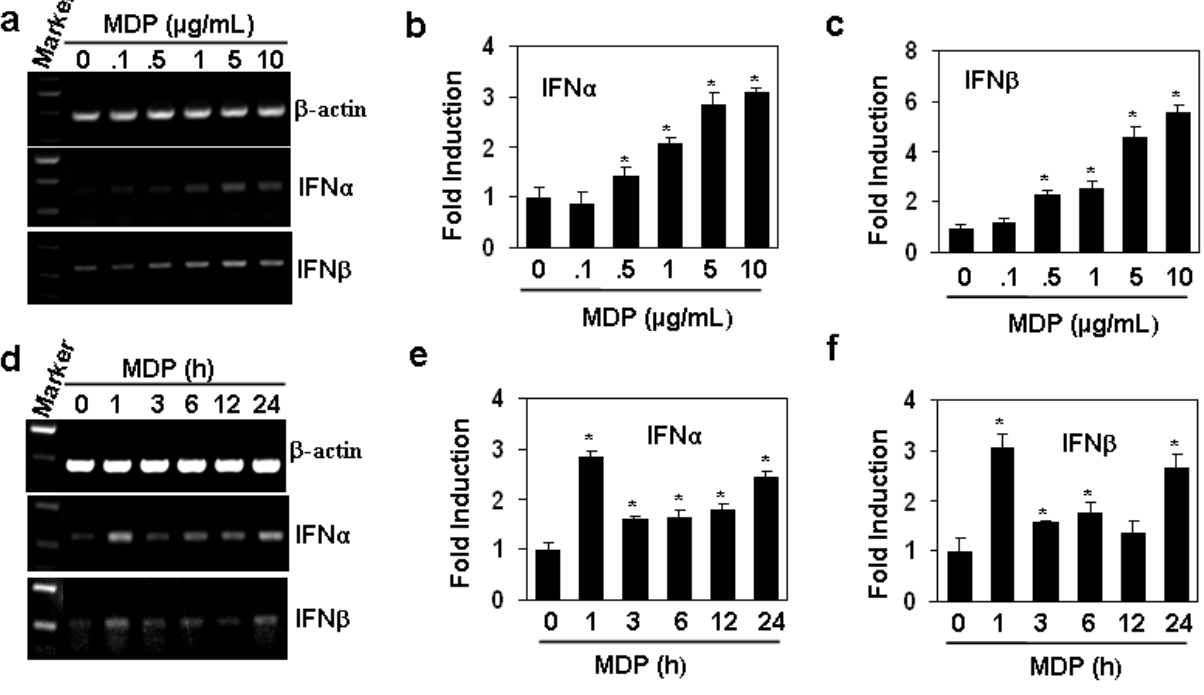
Figure 1. MDP induces the gene expression of type I interferons in human aortic endothelial cells. ( a ) MDP induced dose-dependent up-regulation of interferon gene expression. HAECs were treated with indicated concentrations of MDP for 24 h. The gene expression of IFN α and IFN β was measured by RT-PCR. β -actin gene expression was measured as loading control; ( b,c ) The quantitation of interferon gene expression in (a) by qRT-PCR. * P < 0.05 compared with the control groups, n = 3 in each group; ( d ) MDP induced time-dependent up-regulation of interferon gene expression. HAECs were treated with 10 µg/mL MDP for indicated hours. The gene expression of IFN α and IFN β was measured by RT-PCR. β -actin gene expression was measured as loading control; ( e,f ) The quantitation of interferon gene expression in ( d ) by qRT-PCR. * P < 0.05 compared with the control groups, n = 3 in each